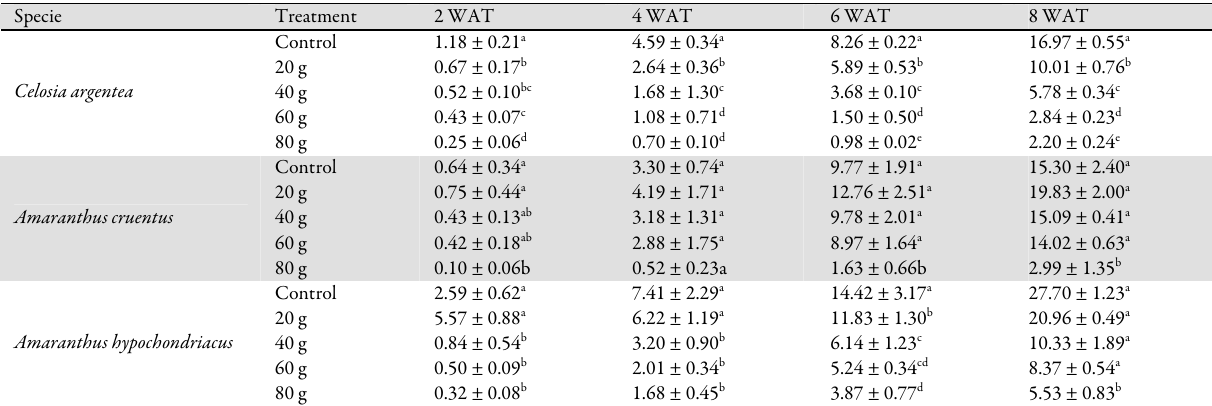
Table 3. Mean leaf area of the studied leafy vegetables to the allelopathic effect of Vitellaria parodoxa leafs Specie Treatment